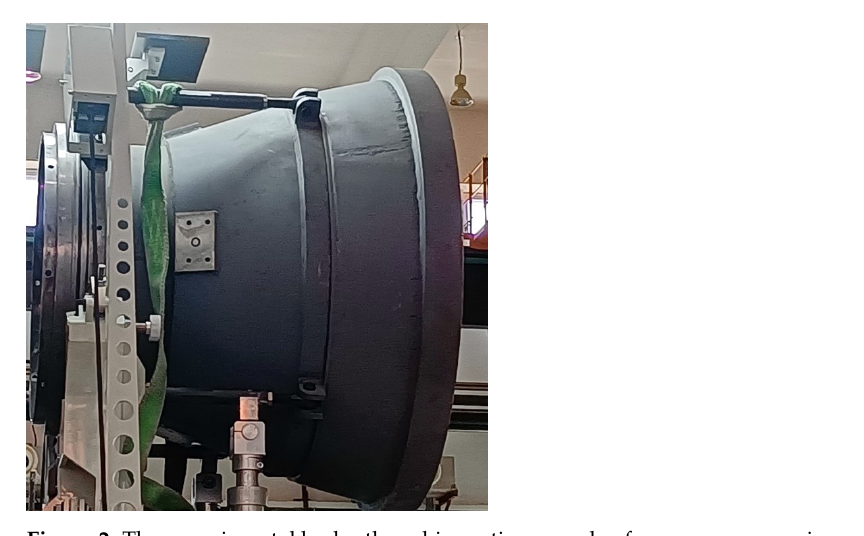
Figure 2. The experimental body: the cabin section sample of an aerospace engine. The 3D data acquisition equipment used in the experiment is the Metra SCAN 3D laser scanner and C-Track optical tracker from the CREAFORM, with a measurement resolution of 0.025 mm, a measurement accuracy of 0.025 mm, and a measurement rate of 1,800,000 times/second. The measuring working range is 0.2–6 m, and the physical map of the product is shown in the following Figure 3.